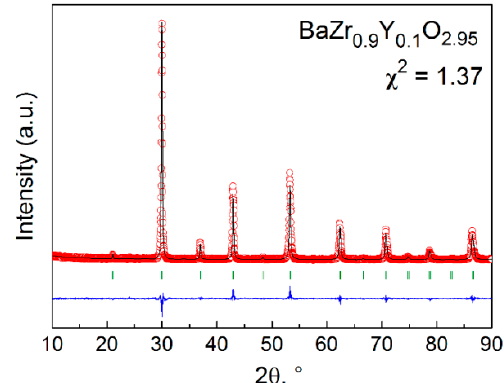
Figure 1. Rietveld refined XRD pattern of BZY10 sample slowly (~100 °C/h) cooled from 1500 °C to room temperature in dry air (log( p H 2 O/atm) = − 4.0): Observed X-ray diffraction intensity (points) and calculated curve (line). The bottom curve is the difference of patterns, y obs -y cal , and the small bars indicate the angular positions of the allowed Bragg reflections